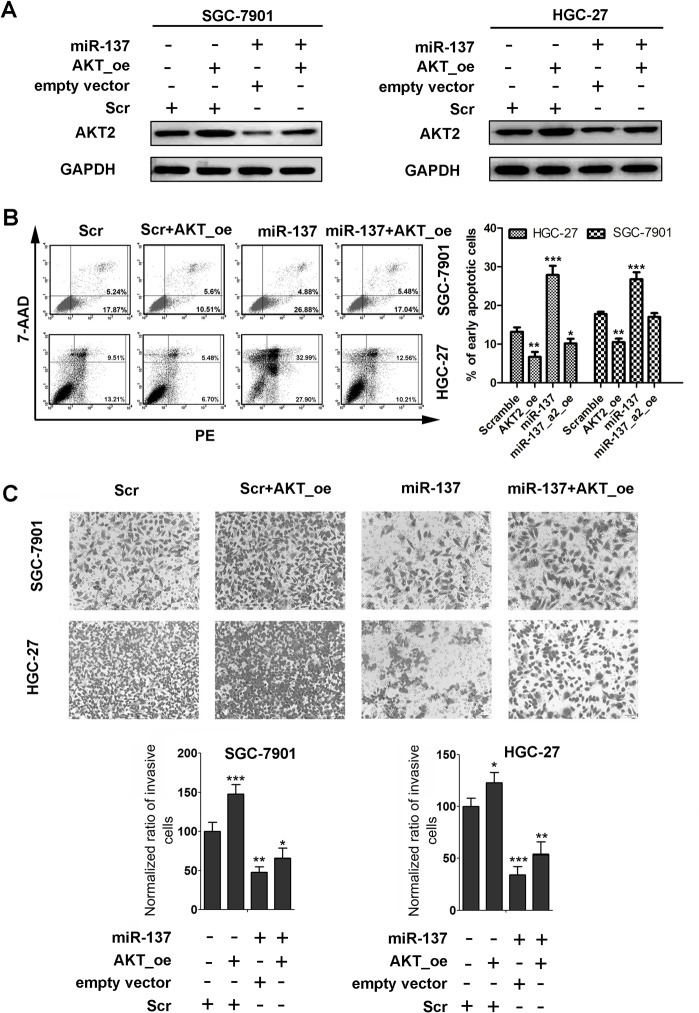
miR-137 active cell apoptosis and negatively regulate cell invasion by targeting AKT2.
A. AKT2 protein level was assessed in GC cells treated by overexpression of miR-137 and/ or AKT2. B. AKT2 restoration leads to a suppression of apoptosis in GC cells while miR-137 promotes apoptosis. C. AKT2 restoration actives the apoptosis and invasion of GC cells while miR-137 showed opposite effects. Representative images are shown. The normalized ratio of invasive cells is shown in the bottom panels. In Fig 5, “miR-137” represents the cells transfected by miR-137 and pcDNA 3.1 empty vector. “AKT2_oe” represents the cells transfected by AKT2 overexpression vector. “miR-137 +AKT2_oe” represents the cells co-transfected by miR-137 and AKT2 overexpression vector. “Scr” represents the cells transfected with mimic negative control and pcDNA 3.1 empty vector.